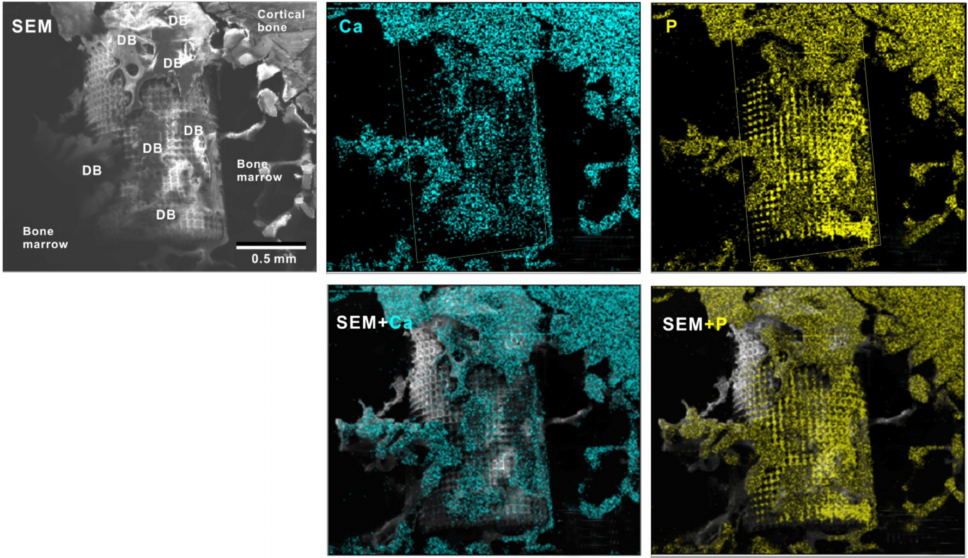
Figure 11. Peri-implant tissue morphology and chemistry around a zirconia implant. To verify bone formation around implants, selected implants were analyzed after the push-in test. A representative result from a meso-/nano-scale hybrid textured implant with 40 µ m-high spikes is presented here. SEM images and elemental mapping for Ca and P signals as well as their superimposed images are